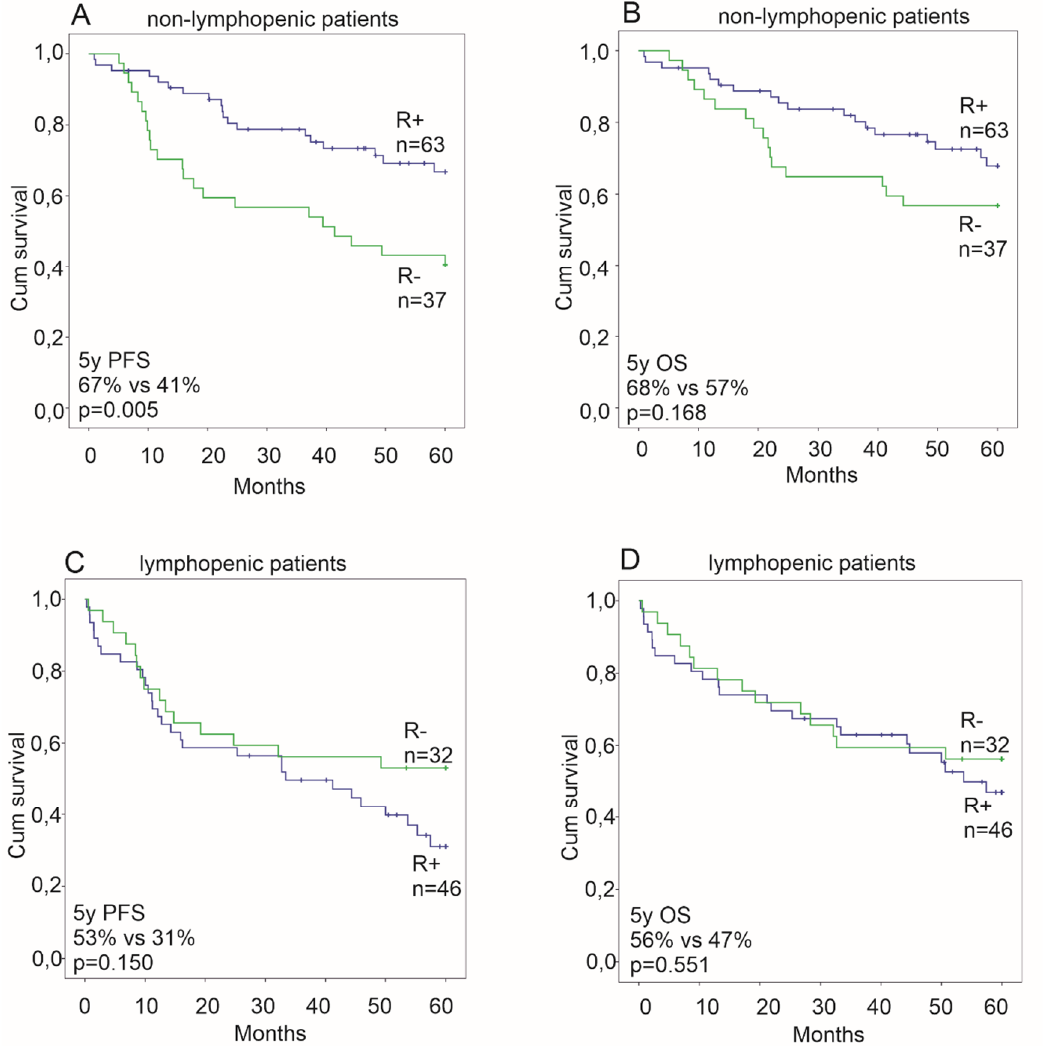
Figure 3. Kaplan-Meier survival estimates comparing patients treated with rituximab (R + ) and patients Figure 3. Kaplan–Meier survival estimates comparing patients treated with rituximab (R+) and treated before rituximab era (R-era) among non-lymphopenic patients ( A , B ) and lymphopenic patients patients treated before rituximab era (R-era) among non-lymphopenic patients ( A, B ) and ( C , D ). Association with an improved progression free survival (PFS) is seen among non-lymphopenic lymphopenic patients ( C, D ). Association with an improved progression free survival (PFS) is seen patients ( A ) without association to the improved overall survival (OS). Among lymphopenic patients among non-lymphopenic patients ( A ) without association to the improved overall survival (OS). no di ff erences in survival were Among lymphopenic patients no differences in survival were seen.